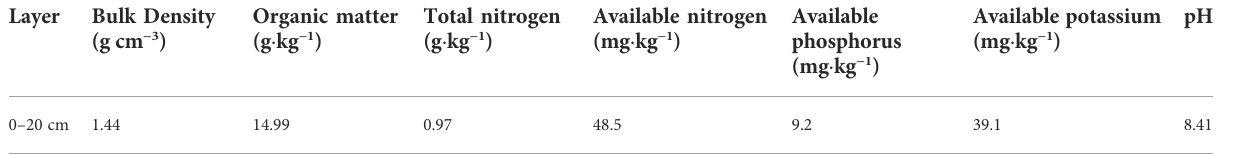
TABLE 1 Soil physical and chemical properties at the beginning of the experiment in 2004. Layer